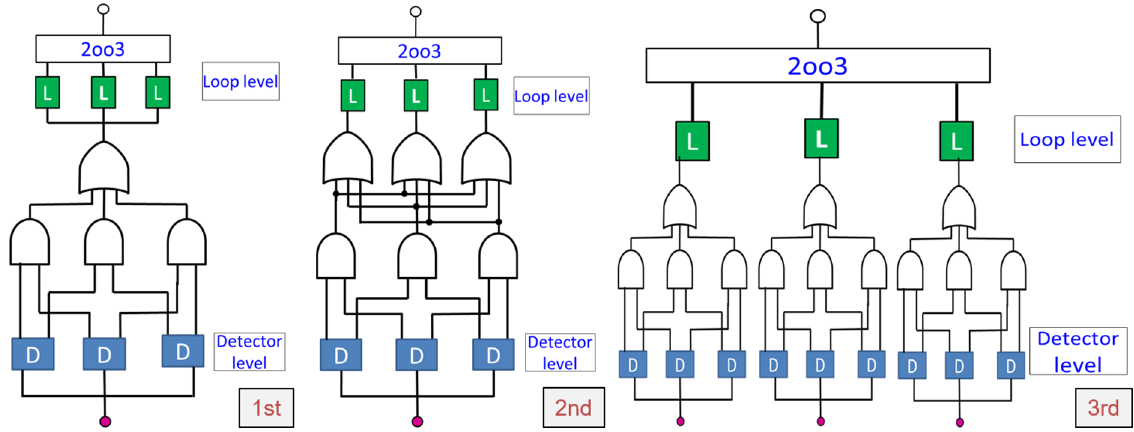
FIG. 19. Models underlying Case III, with three designs of gate logic for the 2oo3